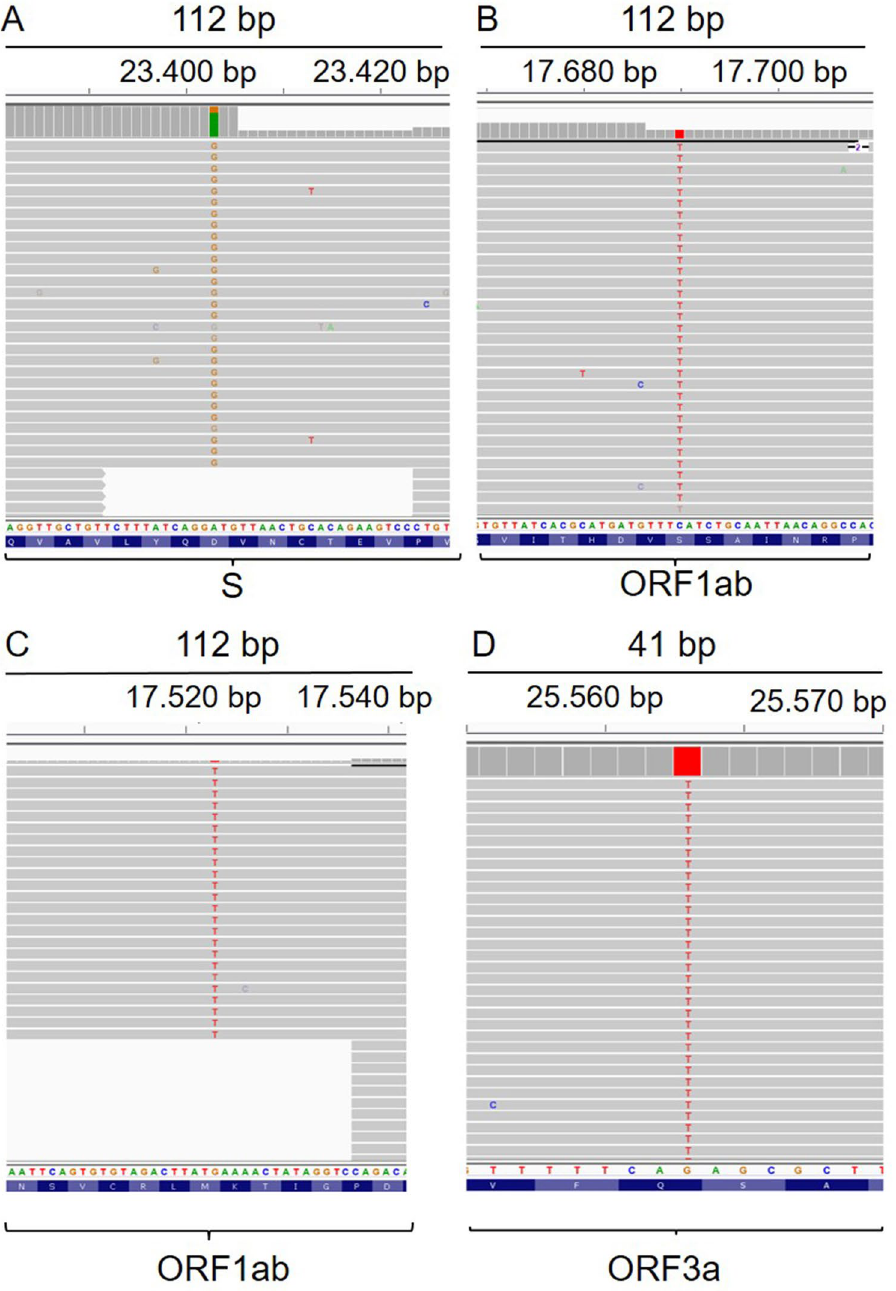
Figure 2. Representative IGV imaging of detected variants. ( A ) ACUTG-1, D614G missense SNV (A23403G) on the surface glycoprotein. ( B ) ACUTG-2, S485L missense SNV (C17690T) on helicase. ( C ) ACUTG-3, M429I missense SNV (G17523T) on helicase. ( D ) ACUTG-4, Q57H missense SNV (G25563T) on ORF3a